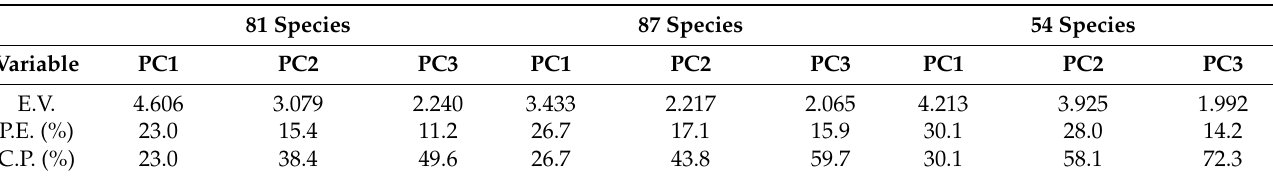
Figure 1. Classification of 81 tropical wood species (listed in Tables 1 and 3) based on 13 anatomical and 7 physical wood characteristics (coded in Table 2), obtained by the UPGMA clustering method (c = 0.798). Table 5. Statistics of the principal component analyses (PCA) for the anatomical and physical wood characteristics (coded in Table 2) of the tropical species sets (as described in Tables 1 and 3). The contributions of components 1–3 to the wood species variation (eigenvalue (E.V.), proportion explained (P.E.), and cumulative proportion